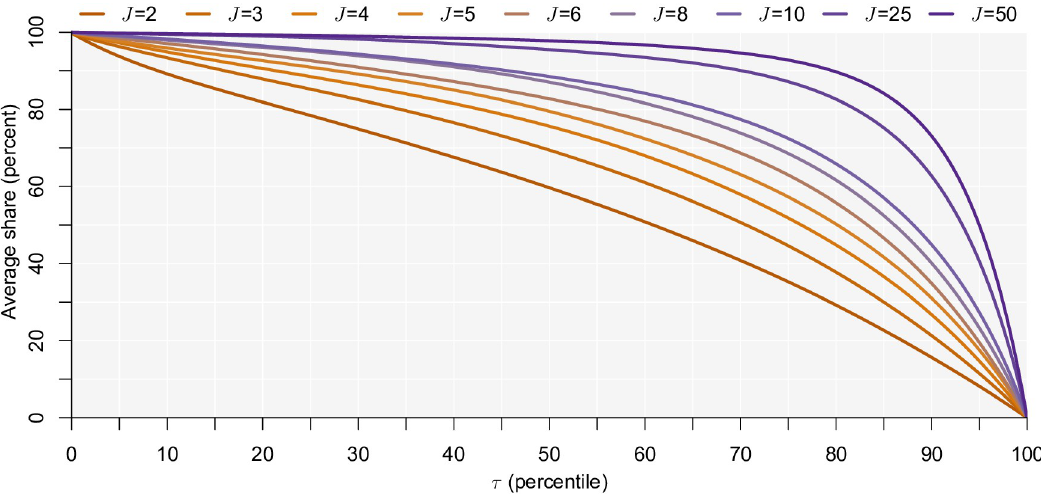
Fig 1. Share of choices consistent with